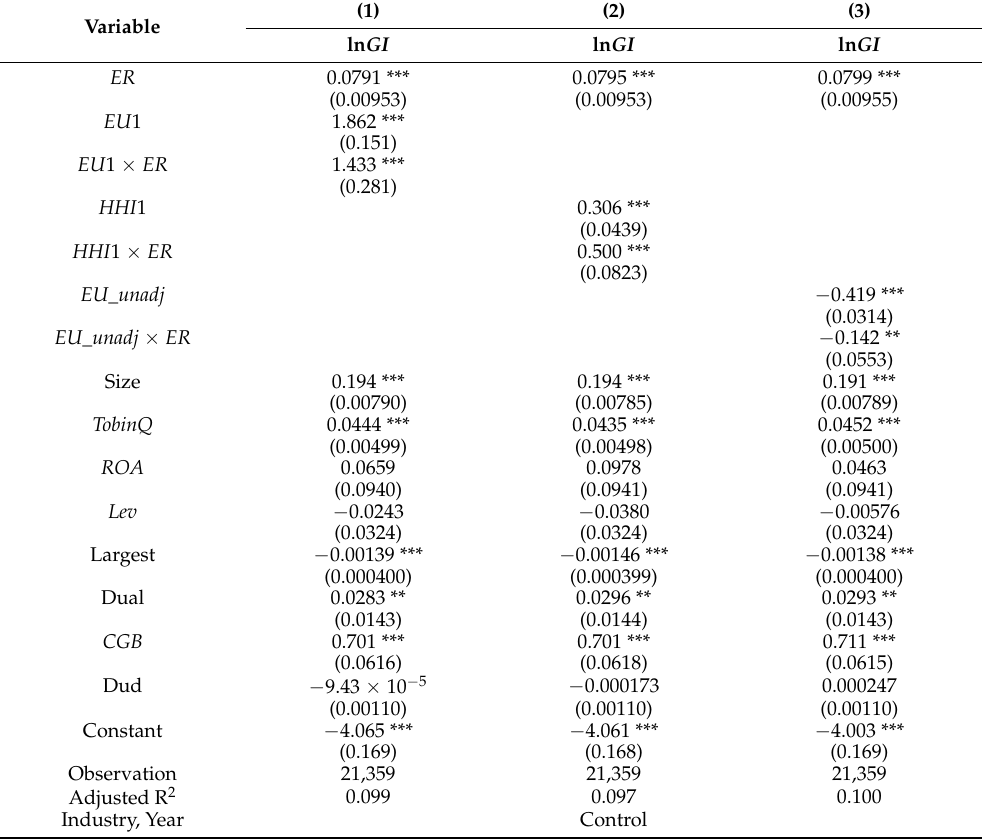
Table A4. Robustness Analysis of Environmental Regulation, Environmental Uncertainty and Enter- prises’ Green Technological